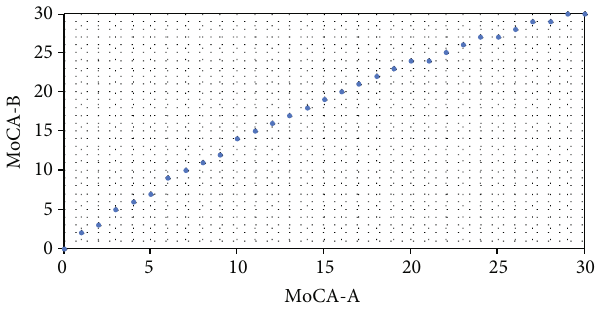
Figure 3: Equated scores between both MoCA